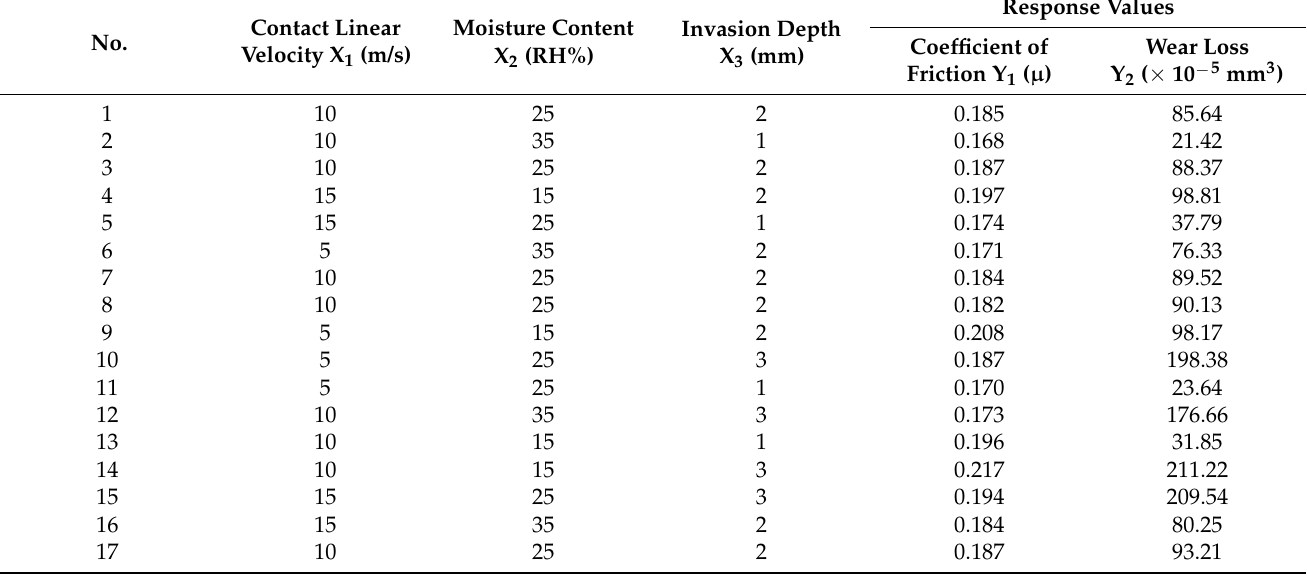
Table 2. Multifactor experimental design and response values for peanut impact-friction